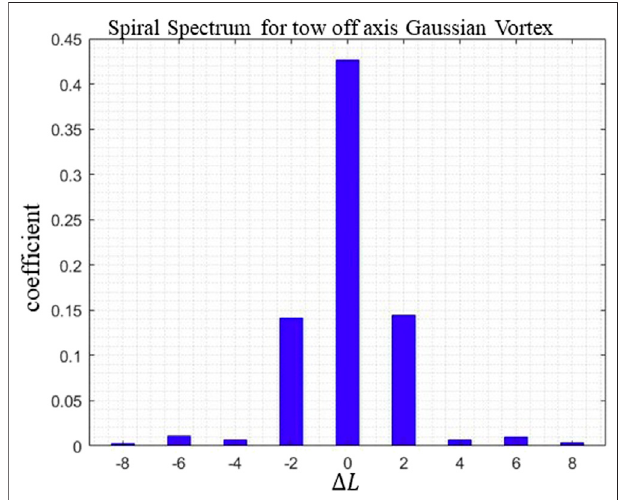
FIGURE4| Thespiralspectrumoflightpropagatingthroughtwooff-axis Gaussian vortex structures, calculated by Eq. 3